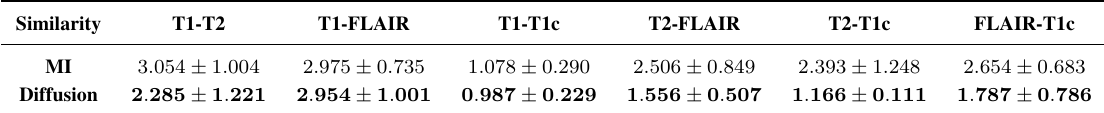
Table 4. Mean (non-rigid) registration error for BRATS data sets. Errors (mean ± standard deviation) are in mm.